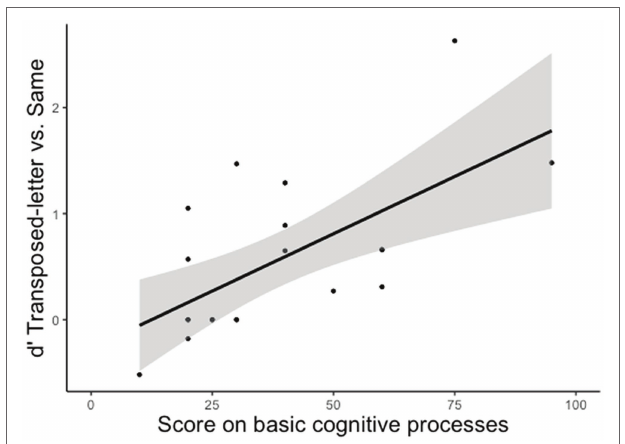
FIGURE 2 | Correlation between the d ' when discriminating transposed- letter pairs from same pairs and the scores on the basic cognitive processes of